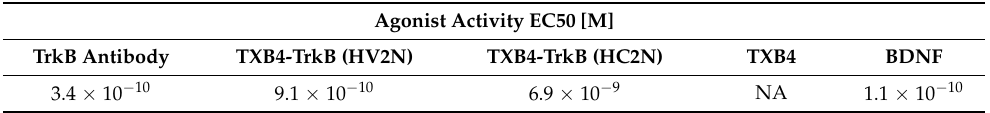
Table 2. Agonist activity using the TrkB-NFAT-bla CHO-K1 reporter cell line assay. A 4-parametric non-linear regression model was used to calculate EC50 values (n = 3 – 5) (see Figure 1E).